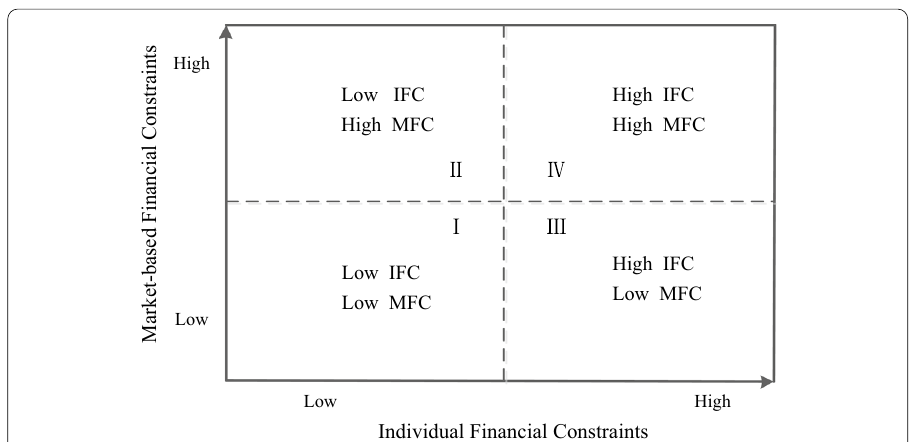
Fig. 4 Different types of financial constraints